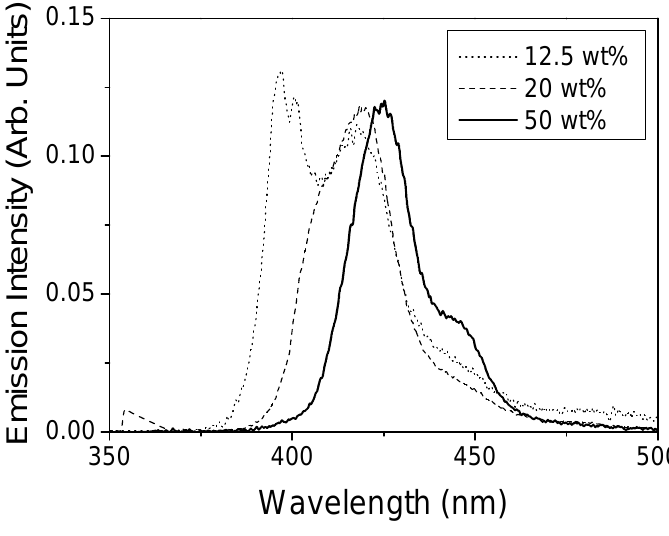
Figure 4. Emission spectra obtained in the setup for the identification of stimulated emission at low pump intensity (below the ASE threshold) for PS films doped with various TPD